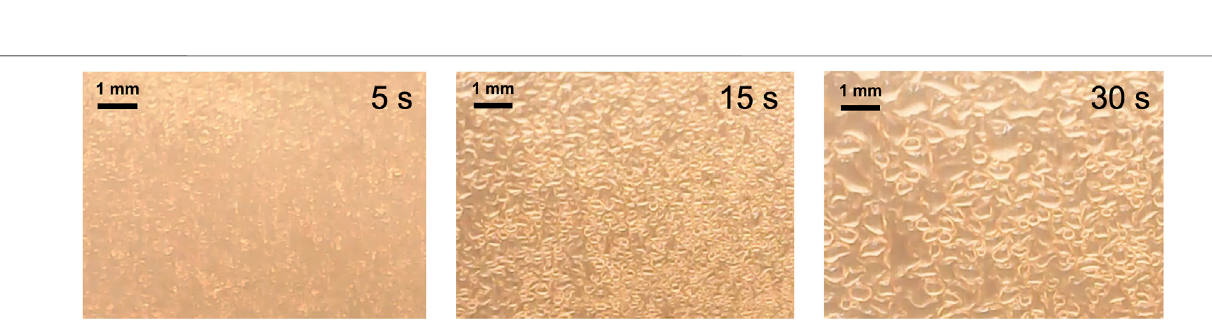
Frontiers in Robotics and AI |